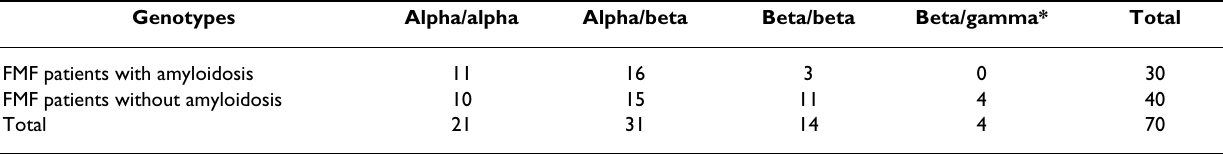
Table 2: Number of SAA1 genotypes observed in FMF patients with and without